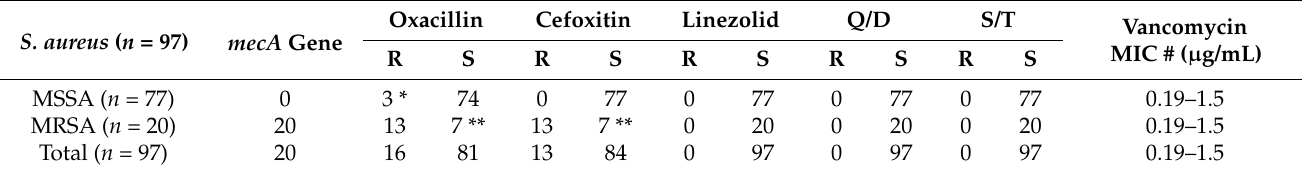
Table 2. Antimicrobial susceptibility profile of MSSA and MRSA isolated from bedridden or institu- tionalized individuals.